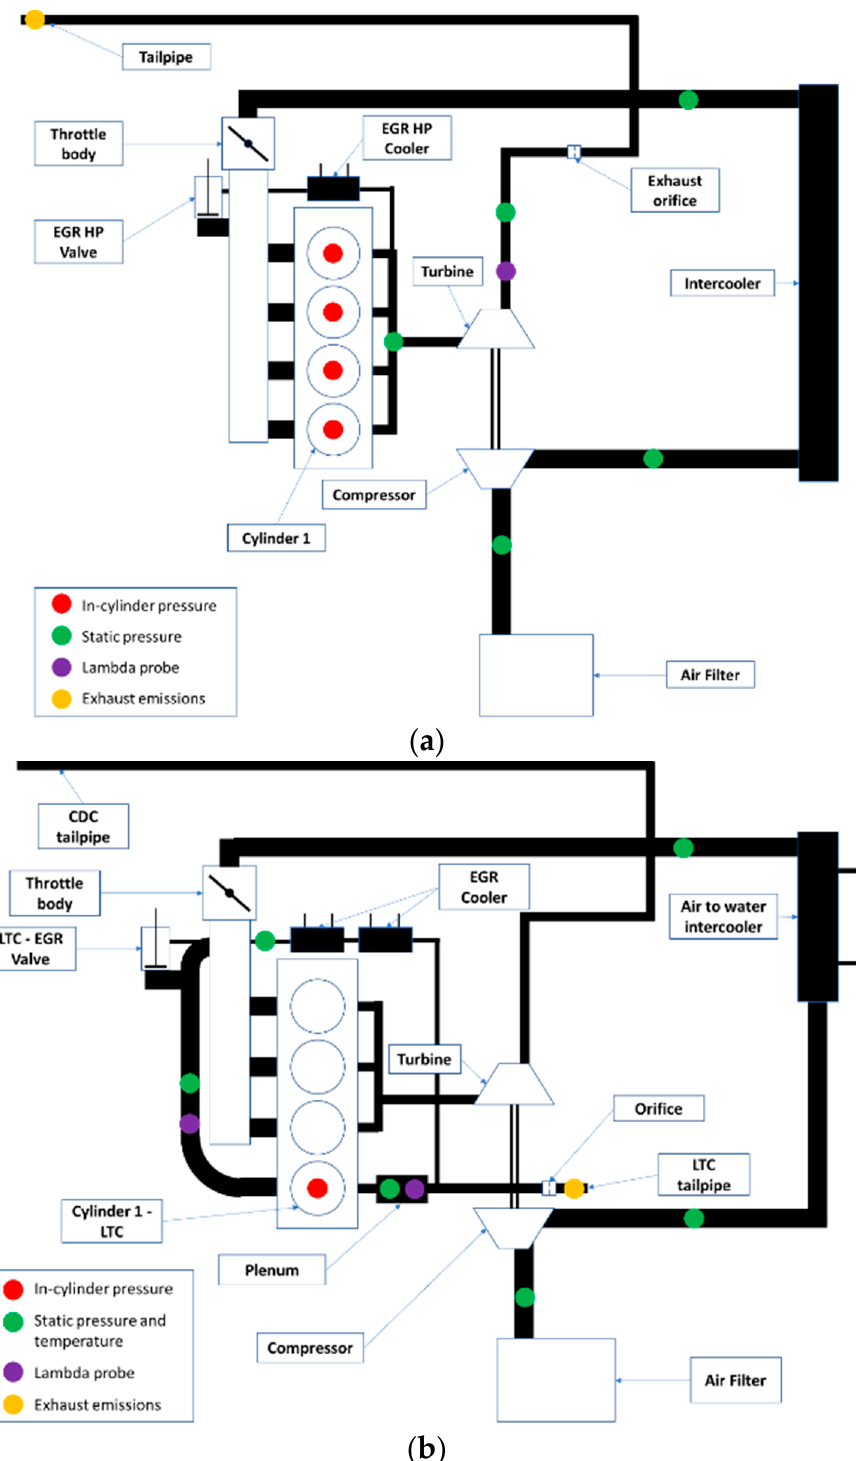
Figure 1. Layout of the engine running in CDC mode ( a ) and when running in the “3 + 1” mode ( b ).